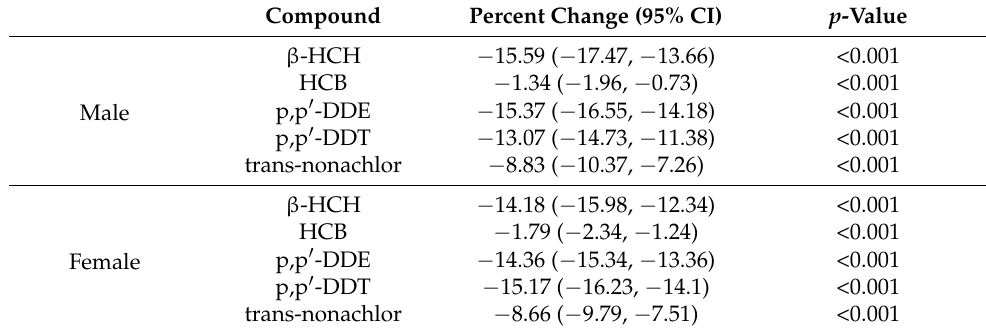
Table 4. Percent Change in Organochlorine Pesticides by the 2-Year Survey Cycle over